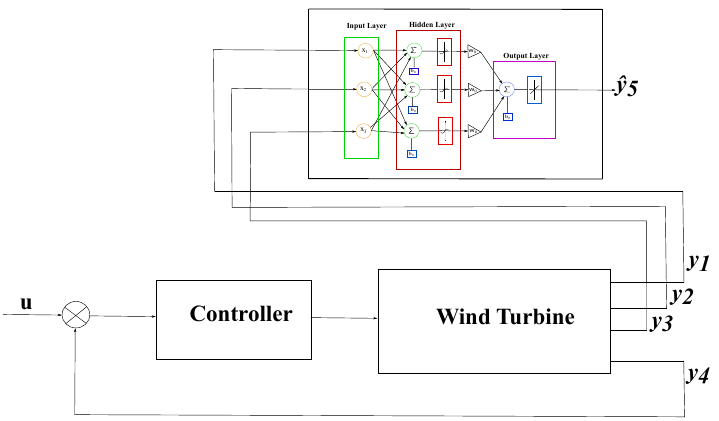
Figure 4. NN-based